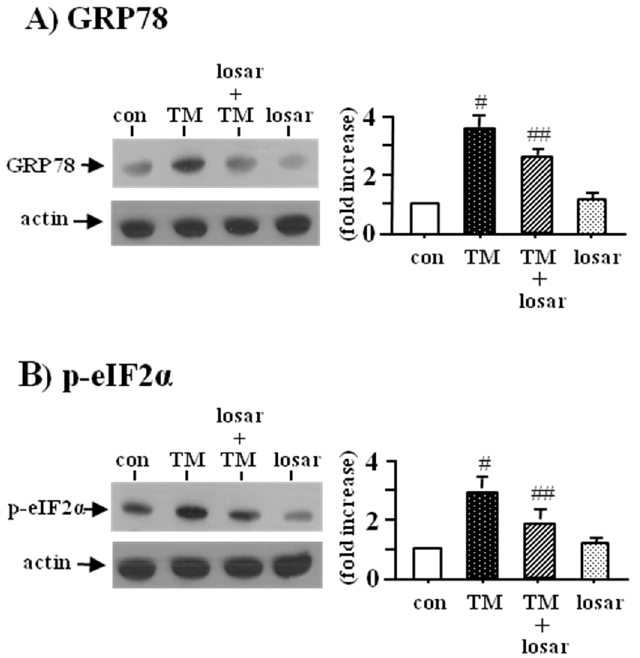
Figure 1. Inhibition of tunicamycin-induced endoplasmic reticulum (ER) stress by losartan. Proximal tubular cells (HK-2 cells) were incubated with tunicamycin (TM, 0.2 µ M) with or without losartan (losar, 10 µ M) for 24 h. Expression of GRP78 ( A ) and p-eIF2 α ( B ) was examined by Western blot analysis. The relative densities of the bands for GRP78 (glucose related protein 78) and p-eIF2 α (phosphospecific-eukaryotic translation initiation factor-2 α ) were normalized to those for actin for standardization. Representative blots and quantitative analysis from three independent experiments were shown. Results were expressed as n -fold increase over control as mean ± S.E. #: p < 0.05 vs. con (control), ##: p < 0.05 vs. TM.